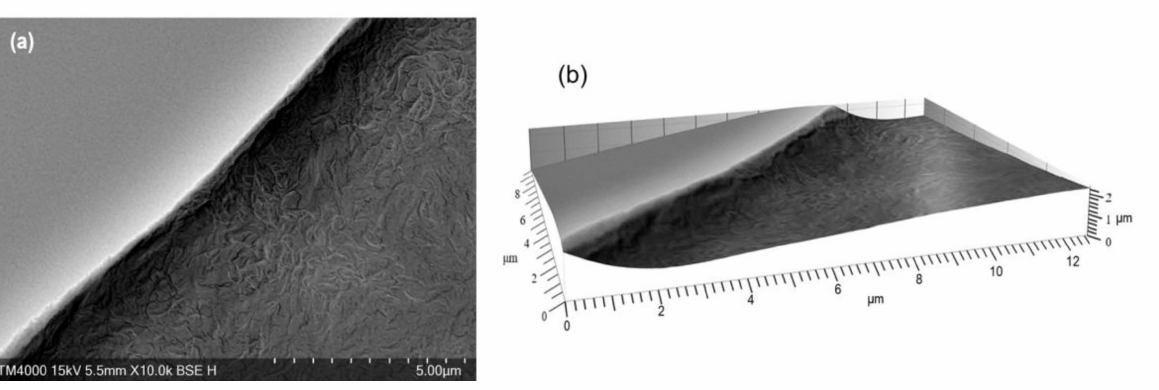
Figure 4. ( a ) SEM observation of the SiO 2 coating edge after laser irradiation. Magnification 10 × K, and ( b ) 3D image of the coating edge viewed diagonally above. Magnification 10 × K.